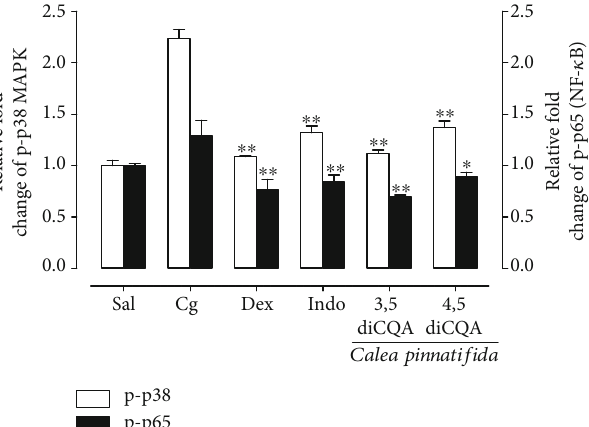
Figure 2: E ff ects of isolated compounds obtained from Calea pinnati fi da leaves on p65 (p-p65 NF- κ B) and p38 (p-p38 MAPK) phosphorylation. 3,5-di- O - E -ca ff eoylquinic acid (3,5-diCQA: 2.5 mg/kg) and 4,5-di- O - E -ca ff eoylquinic acid (4,5-diCQA: 5mg/kg) administered 0.5h before pleurisy induction. Sal: negative control group, animals treated only with sterile saline; Cg: positive control group, animals treated only with carrageenan (1%); Dex: animals treated with dexamethasone (0.5mg/kg) 0.5h before pleurisy induction; Indo: animals treated with indomethacin (5 mg/kg) 0.5h before pleurisy induction. Bars indicate the mean ± SEM of six animals. ∗ P < 0 : 05 and ∗∗ P < 0 : 01